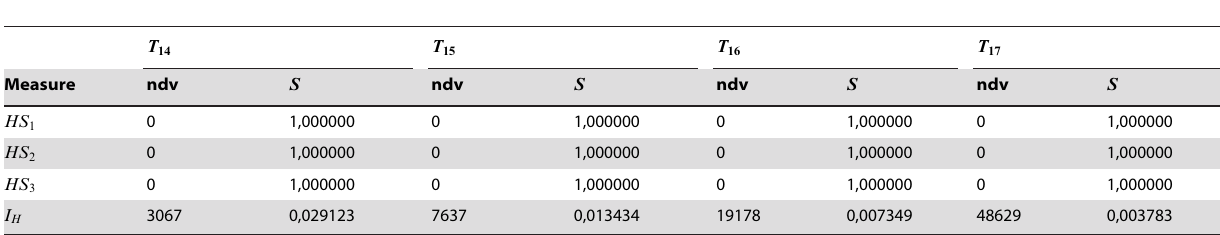
Table 2. Exhaustively generated sets of non-isomorphic trees: D T 14 D ~ 3159 , D T 15 D ~ 7741 , D T 16 D ~ 19320 , D T 17 D ~ 48629 .